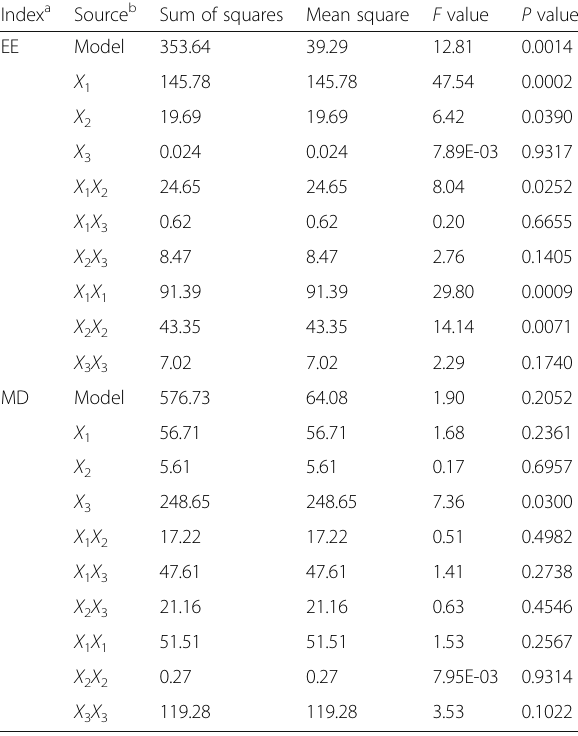
Table 3 Analysis of variance (ANOVA) for response quadratic surface